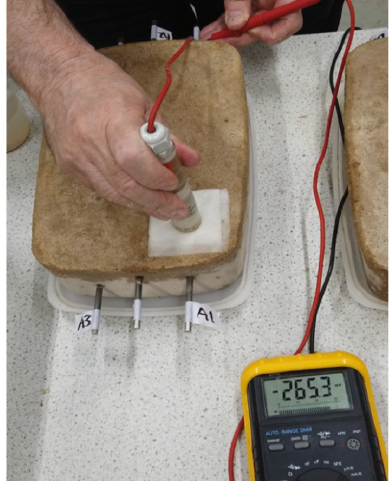
Figure 2. Half-cell potential mapping (Sample A). Table 1. Half-cell potential results.